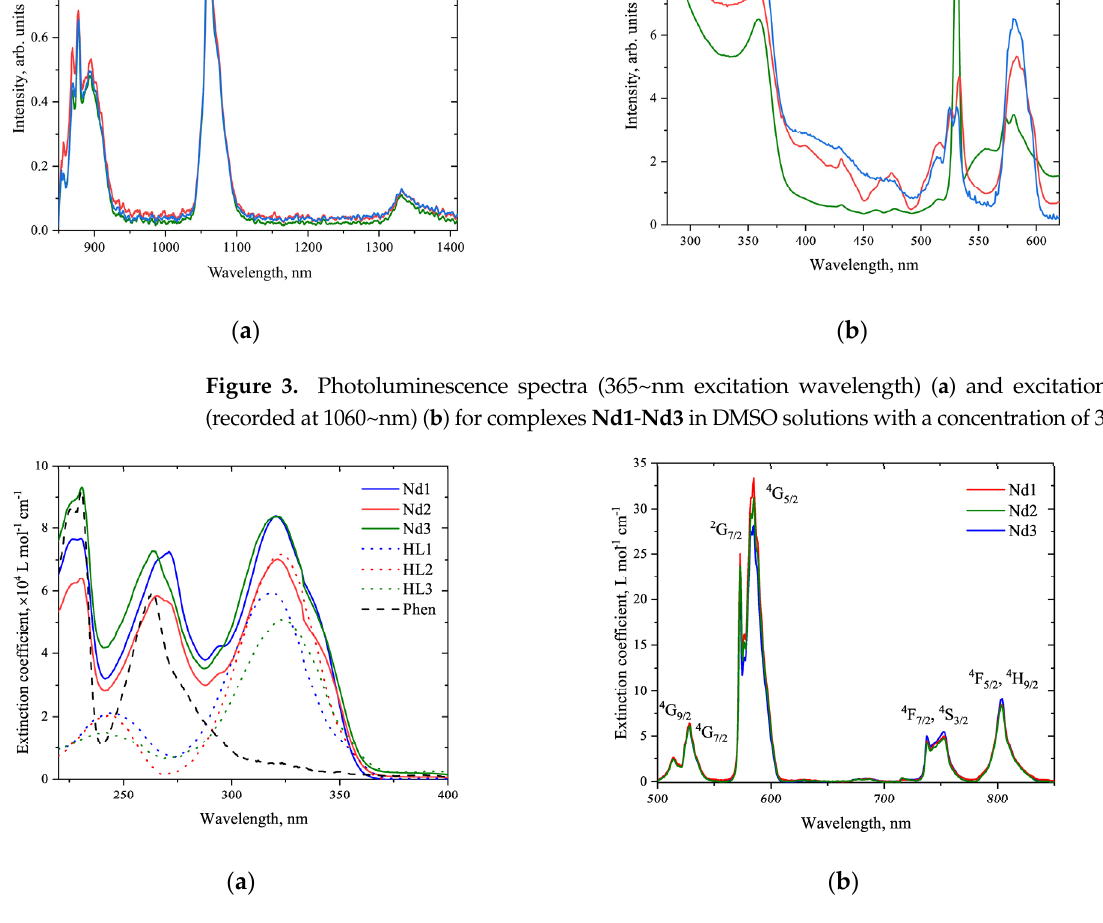
Figure 4. Absorption spectra in UV region ( a ) and Vis–NIR region ( b ) for acetonitrile solutions of Nd1 - Nd3 complexes, 1,10-phenanthroline ligand (phen), and pyrazolic 1,3-diketonate ligands with C x F 2x+1 groups ( HL 1 - HL 3 ; x = 1,3,6). The concentrations were 5 ·10 − 5 M and 5·10 − 3 M.